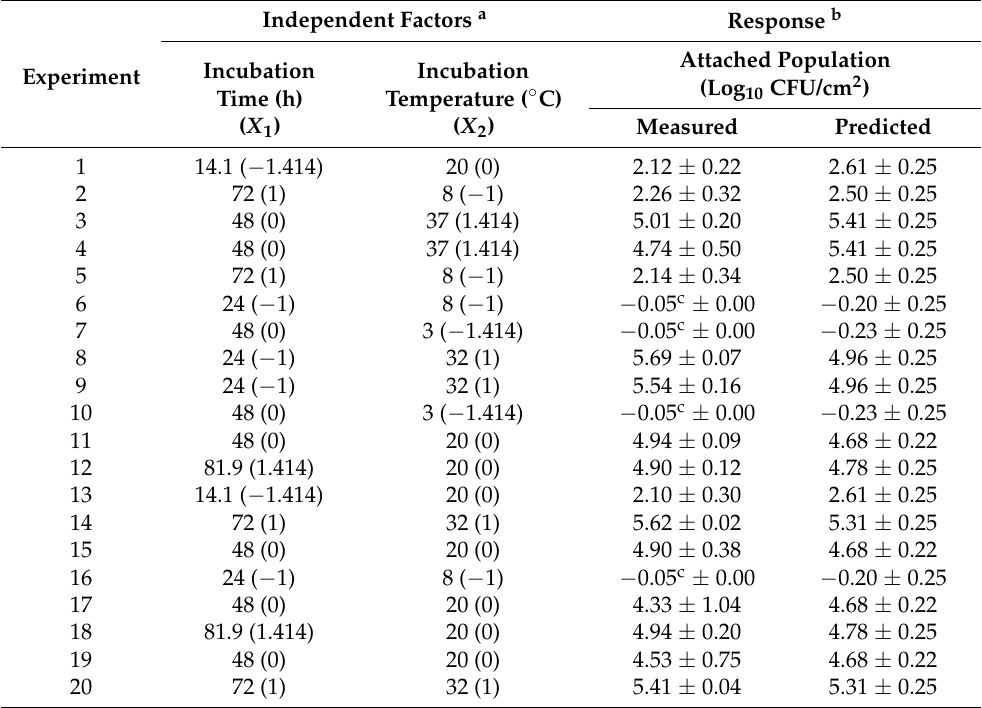
Table 1. Experimental design with real and coded values of the two independent factors (i.e., time and temperature) evaluated for their influence on the attached to stainless steel (SS) coupons population (Log 10 CFU/cm 2 ) of the four-strain L. monocytogenes cocktail. Measured and predicted values of Log 10 CFU/cm 2 , as defined for each individual experiment, are also